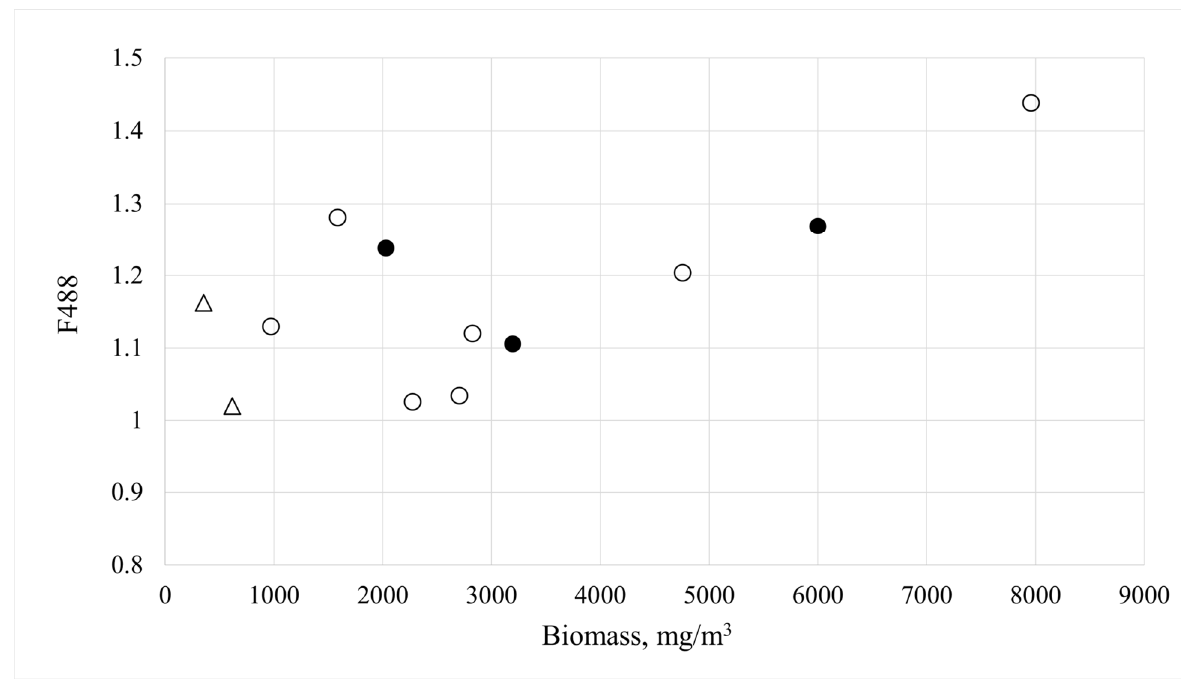
Figure 5. Relationship between spectrum shape parameter F 488 and biomass of Karenia spp. Circle = biomass of Karenia spp. >50% in total phytoplankton. Triangle = <50%. Filled circles = coincidence measurements in space and